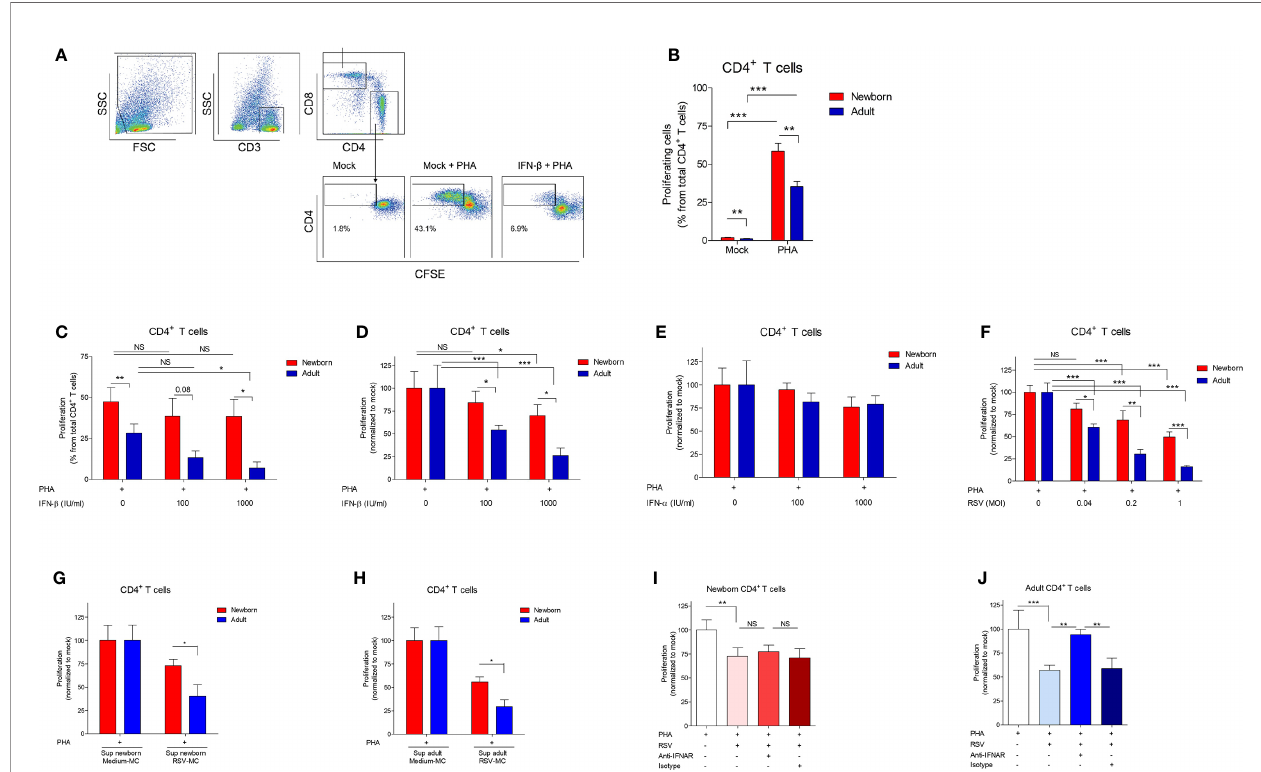
FIGURE 1 | IFN- b -mediated inhibition of CD4 + T cell proliferation is reduced in newborns. (A) Representative gating strategy: CD3 + cells were identi fi ed from MCs followed by CD4 + and CD8 + cells to identify respectively CD4 + T cells and CD8 + T cells. CFSE fl uorescence was used to determine the percentage of proliferating T cells. (B) Percentage of proliferating CD4 + T cells after incubation of CBMC (newborn) or PBMC (adults) with PHA for 72h. (N=14-19). (C – F) CMBCs or PBMCs were pre-incubated with medium, IFN- b (C-D), IFN- a (E) , or RSV (F) for 24h and, subsequently, incubated with PHA for 72h to induce proliferation. Proliferation of CD4 + T cells after pre-incubation with medium was normalized for (D – F) . For this, the proliferation of T cells in the condition with only medium was set to 100%. (N=5-6). (G, H) CBMCs (G) or PBMCs (H) were pre-incubated with supernatant derived from MCs exposed to medium or supernatant derived from MCs exposed to RSV and, subsequently, incubated with PHA for 72h to induce proliferation. Proliferation of CD4 + T cells after pre-incubation with supernatant derived from MCs exposed to medium was set to 100%. (N=5-7). (I, J) CBMCs (I) or PBMCs (J) were incubated with medium, blocking antibodies against IFNAR2 or isotype controls for 1h followed by exposure to medium or RSV for 24h and PHA for 72h to induce proliferation. Proliferation of CD4 + T cells after pre-incubation with medium was set to 100%. (N=5-6). Data are presented as means ± SEM. NS = not signi fi cant. * = P <0.05. ** = P <0.01. *** = P <0.001. ns, not signi fi